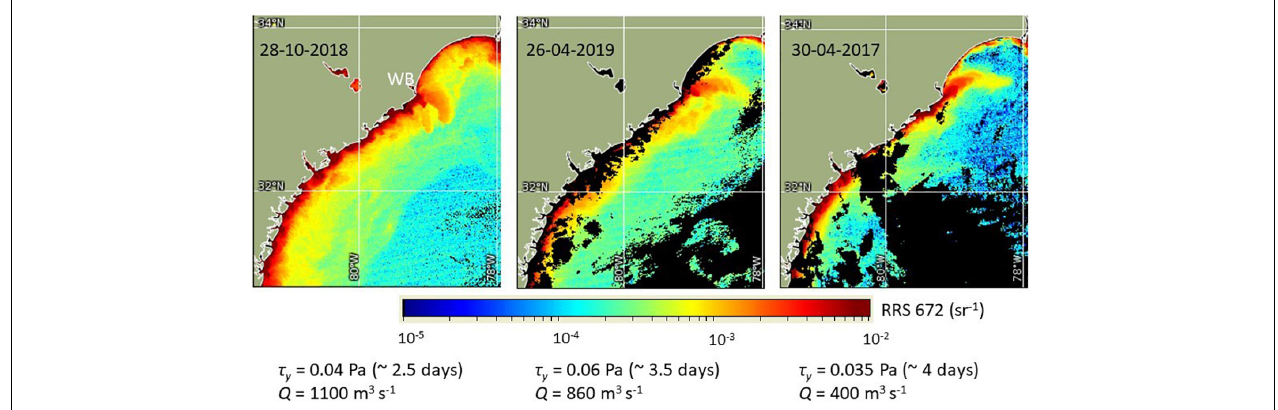
FIGURE 1 | VIIRS images of sediment index Rrs at 672 nm of the South Atlantic Bight shelf and the Winyah Bay (WB) plume. The forcing conditions shown below images are: freshwater discharge Q (Pee Dee only) over the preceding 5-day period, and the magnitude (duration) of the upwelling-favorable wind stress defined as its meridional component τ y